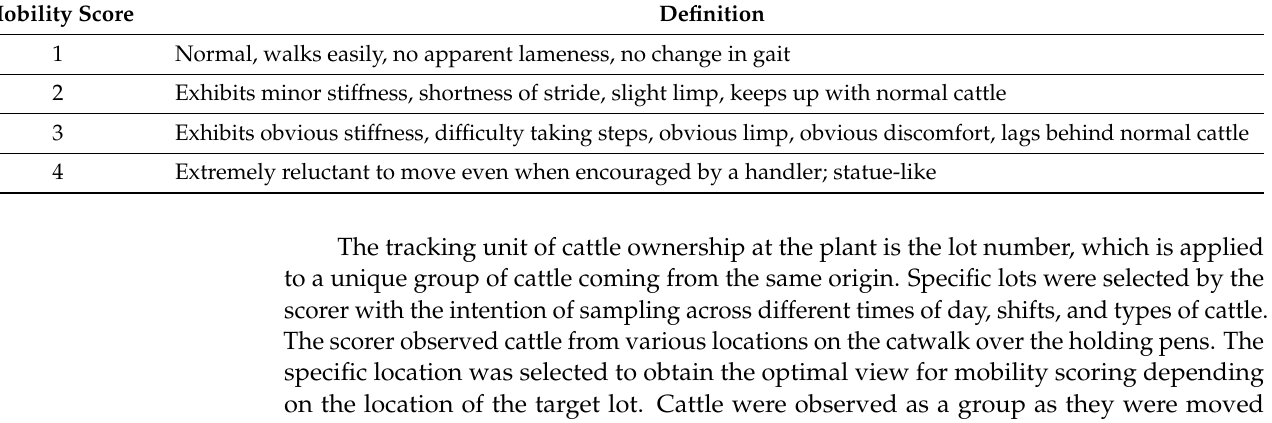
Table 1. The North American Meat Institute (NAMI) Mobility Scoring System for scoring cattle mobility in finished cattle [19]. Mobility